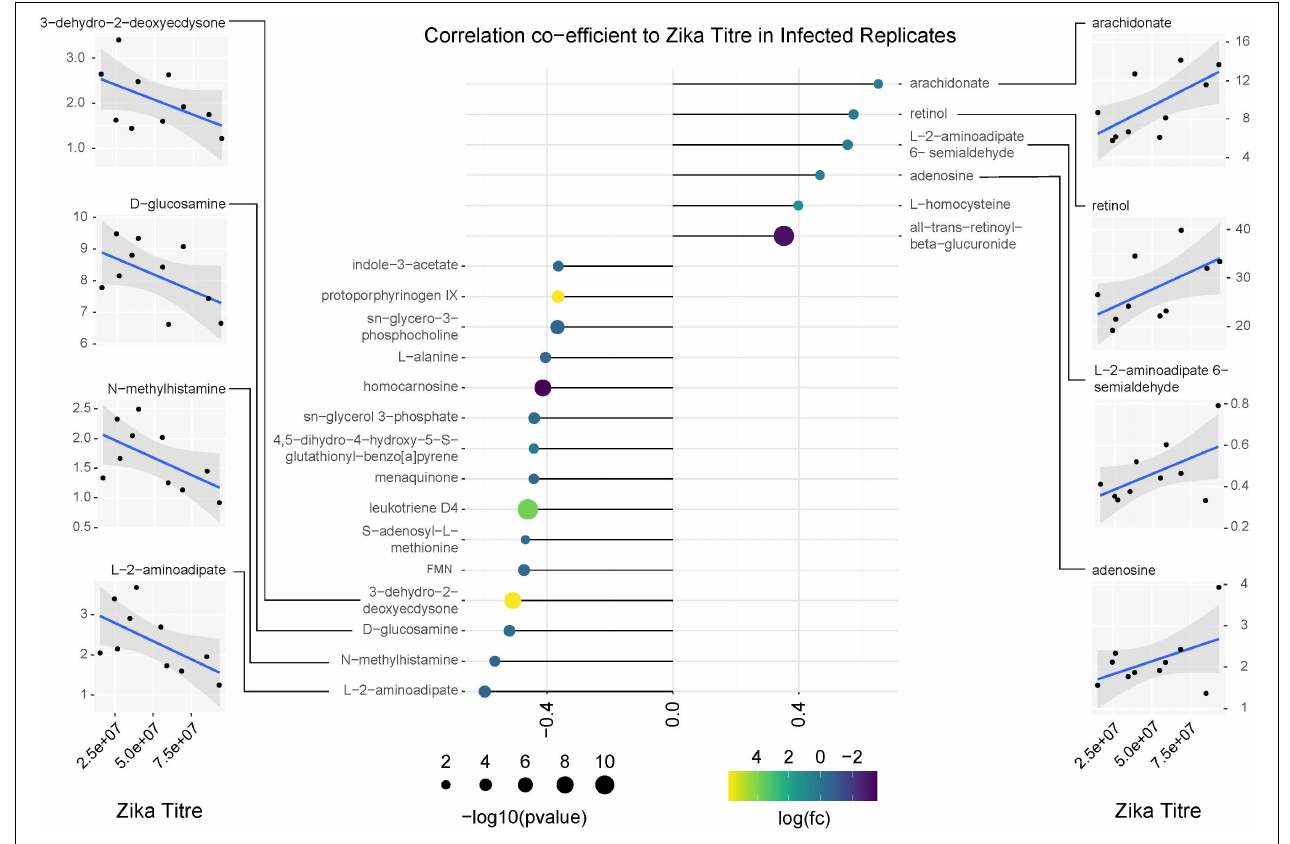
FIGURE 9 | Correlation analysis of compounds associated with ZIKV infection relative to replicate infection titers as measured by qPCR. Lollipop chart visualizing correlation coefficients of compounds with significant changes in abundance in ZIKV positive mosquitoes. Compound abundance was compared against the average ZIKV titer from each biological replicate of infected samples. Only compounds with a correlation coefficient outside of –0.35 or 0.35 were plotted. Point size represents the significance of the change in compound abundance between infected and uninfected samples. Point coloration represents log of the fold change observed in infected samples. Individual plots for compounds with the highest positive and negative correlations relative to ZIKV titer are found on the left and right sides of the figure. Blue trendlines represent general linearized models of the correlation. Shaded areas represent 95% confidence